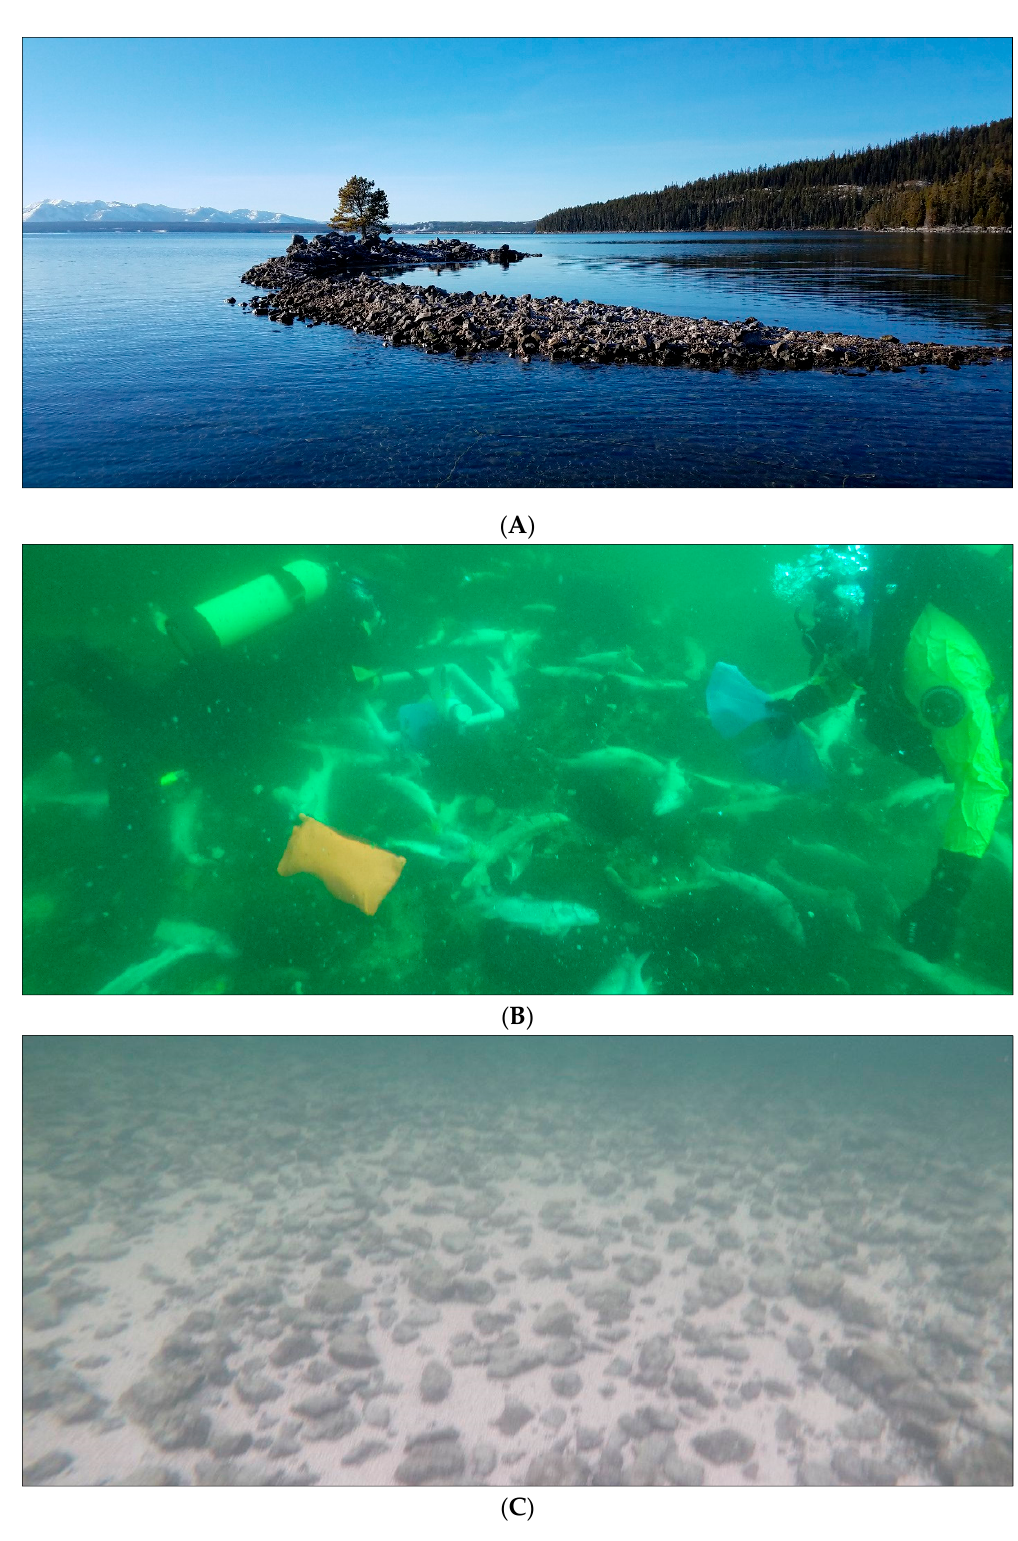
Figure A9. ( A ) The angular-rock substrate surrounding Carrington Island in the West Thumb is prime lake trout spawning habitat in Yellowstone Lake. ( B ) Scuba divers inspect the spatial coverage of lake trout carcasses, and ( C ) organic (soy and wheat gluten) pellets spread by helicopter to induce decomposition, reduce dissolved oxygen concentrations, and increase mortality of lake trout embryos.